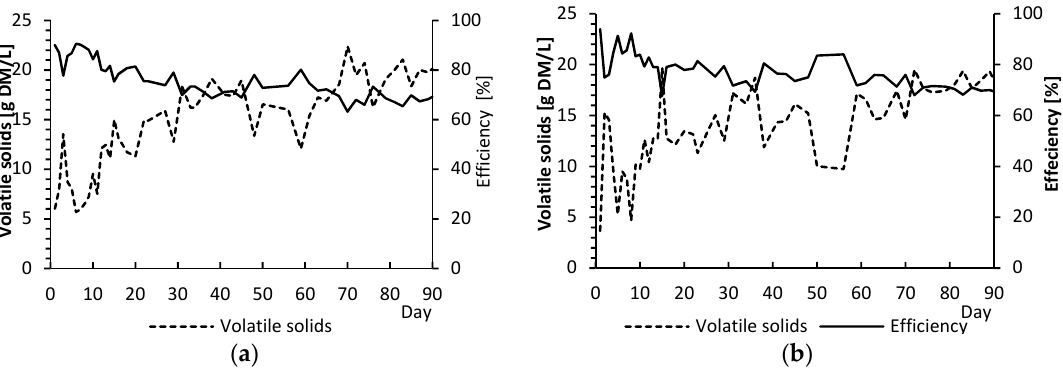
Figure 7. Efficiency of removal of organic compounds during the anaerobic digestion of ORF after autoclaving; ( a ) mesophilic—temperature 37 °C, ( b ) thermophilic—temperature 55 °C.